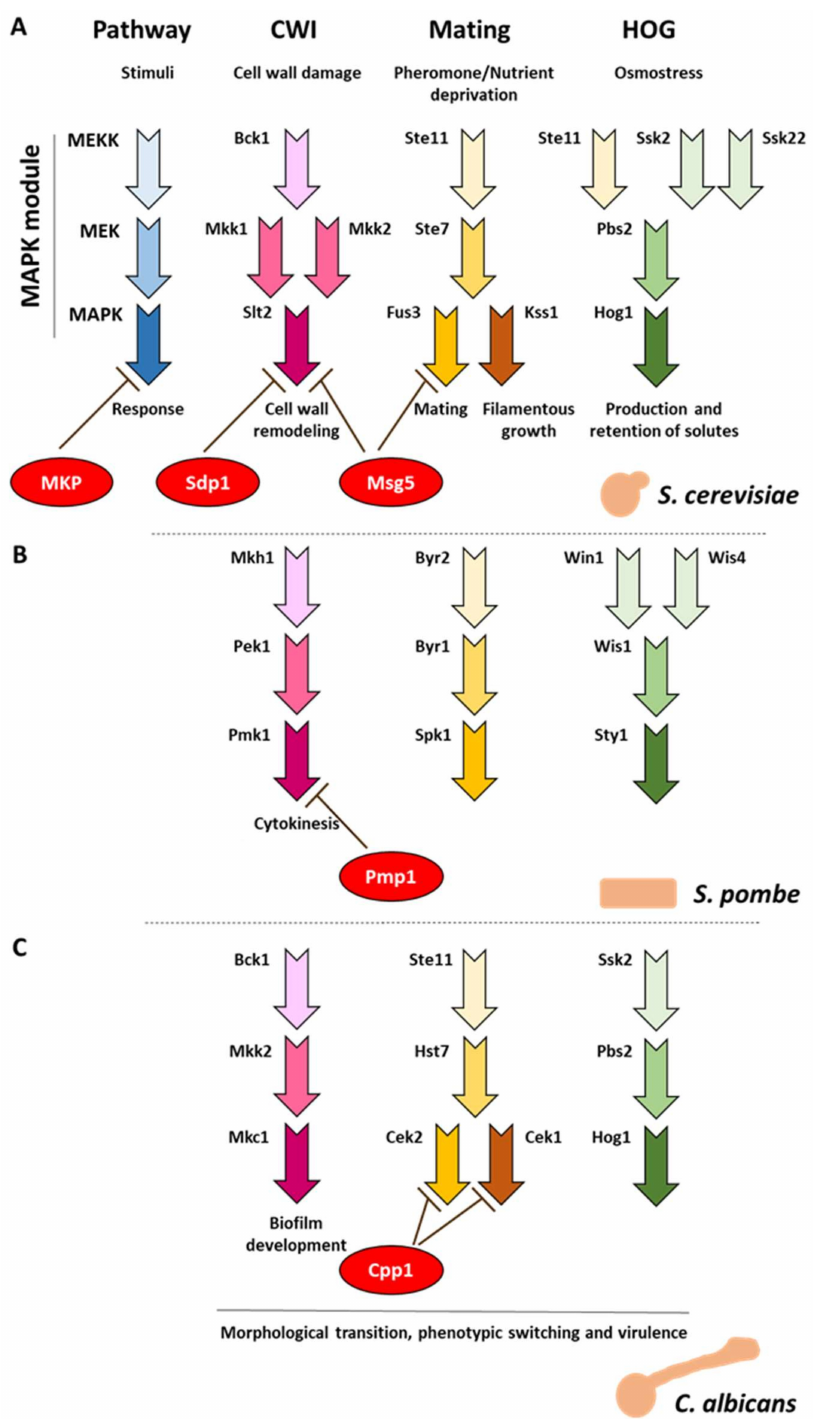
Figure 1. Mitogen-activated protein kinase (MAPK) signaling pathways in model fungi. At the uppermost left side, a schematic view of a MAPK pathway with the components of the MAPK module in blue and the MAP kinase phosphatase (MKP) in red. On the right side (head level), the major MAPK pathways described in fungi, Cell Wall Integrity (CWI), mating/filamentous growth and High Osmolarity Glycerol (HOG), and the stimuli that trigger their activation. The equivalent MAPK pathways are shown for the budding yeast Saccharomyces cerevisiae ( A ), the fission yeast Schizosaccharomyces pombe ( B ), and the dimorphic yeast Candida albicans ( C ). The same code of colors is shown in all cases, as indicated